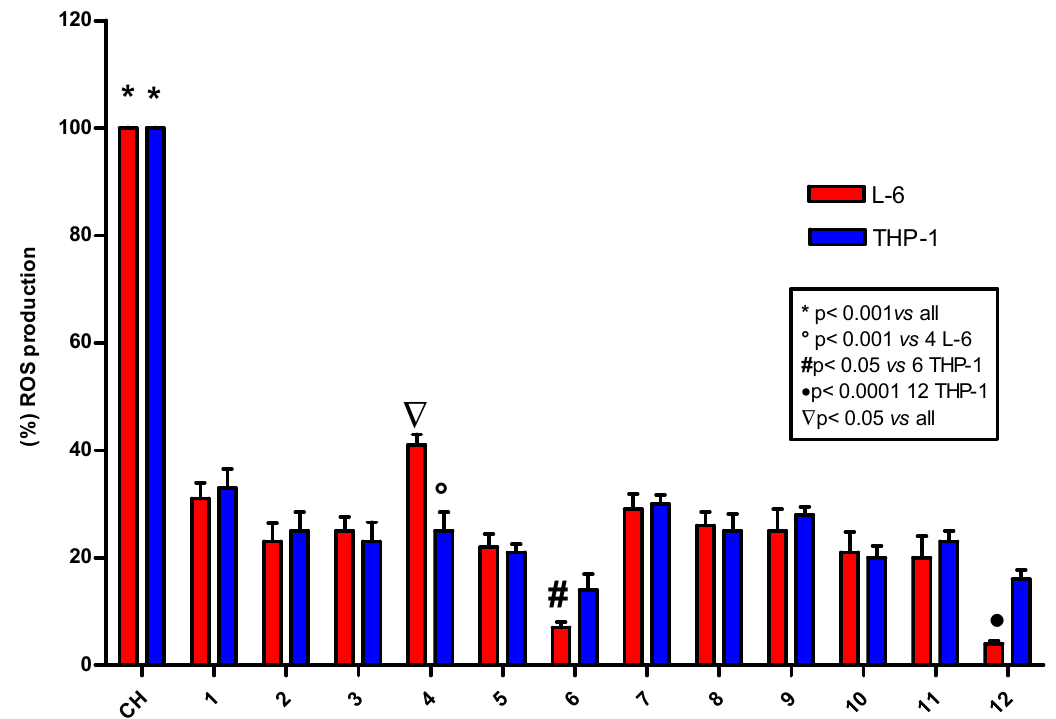
Figure 3. Determination of intracellular ROS in L6 and THP-1 cell lines after stimulation of DCF fluorescence with 200 µ M cumene hydroperoxide (CH) alone or in presence of phenethyl alcohols 1 – 6 or the corresponding trifluoroacetate esters 7 – 12 at 10 µ M concentration. Data are reported as mean values ± SD of five experiments carried out in triplicate. Statistical analysis performed with one-way ANOVA and Bonferroni post-test, except for 4 , 6 , and 12 where Student’s t test was used.